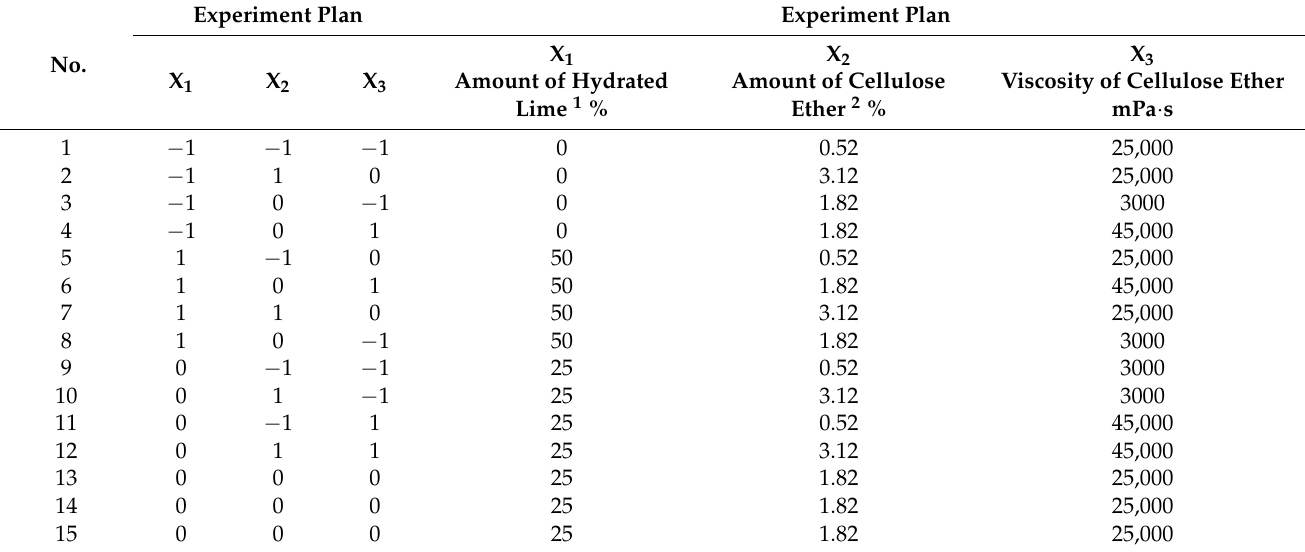
Table 4. Box–Behnken experiment